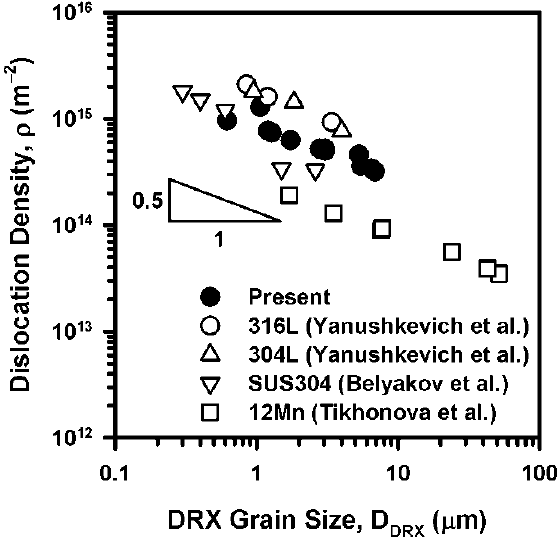
Figure 11. Relationship between the DRX grain size and the dislocation density in a highly-alloyed austenitic stainless steel subjected to hot compression along with some reference data [19,21,26].